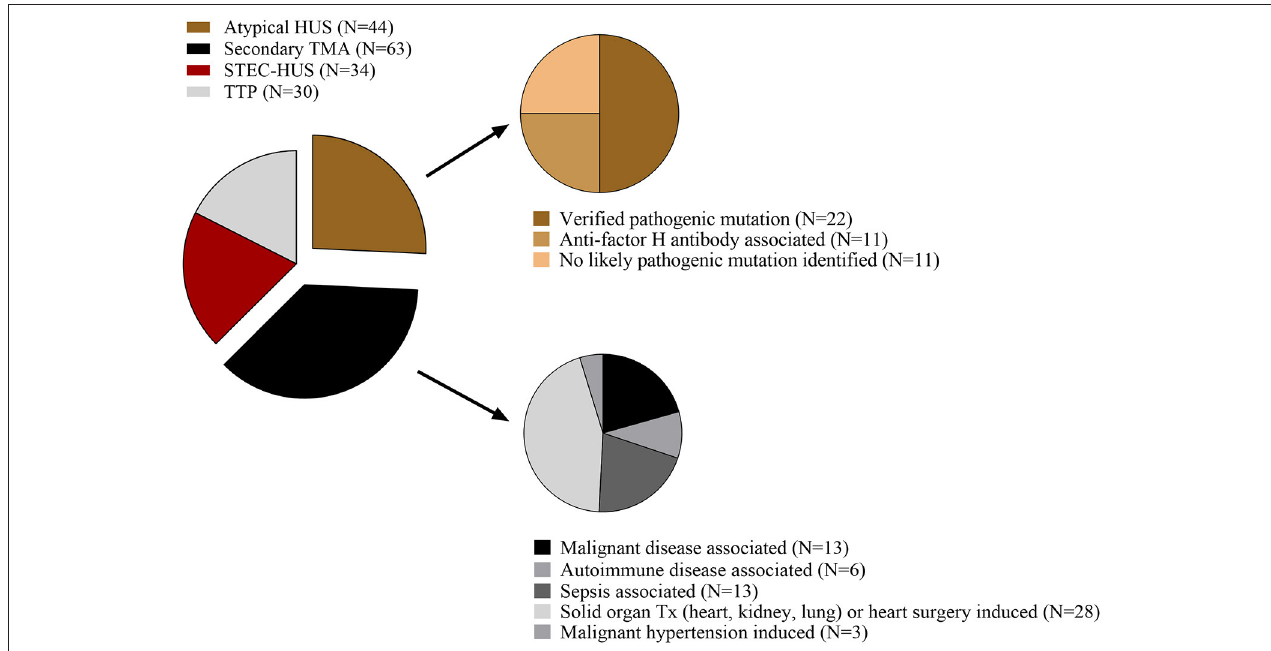
FIGURE 1 | Representation of TMA disease etiology in the studied population. The number of participants per group (N) is shown as proportion of a whole. HUS, hemolytic uremic syndrome; STEC-HUS, Shiga-like toxin associated HUS; TMA, thrombotic microangiopathy; TTP, thrombotic thrombocytopenic purpura; Tx,